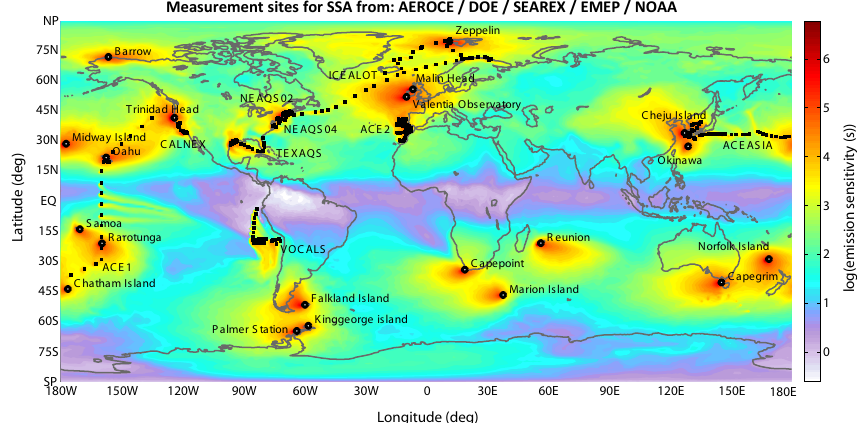
Fig. 4. Global map showing the locations of the stations (circles) and research cruises (dotted) (for station details, see Table 2). Also shown on a color scale is the combined footprint emission sensitivity of all the samples. This shows for which areas the observations provide information on the SSA